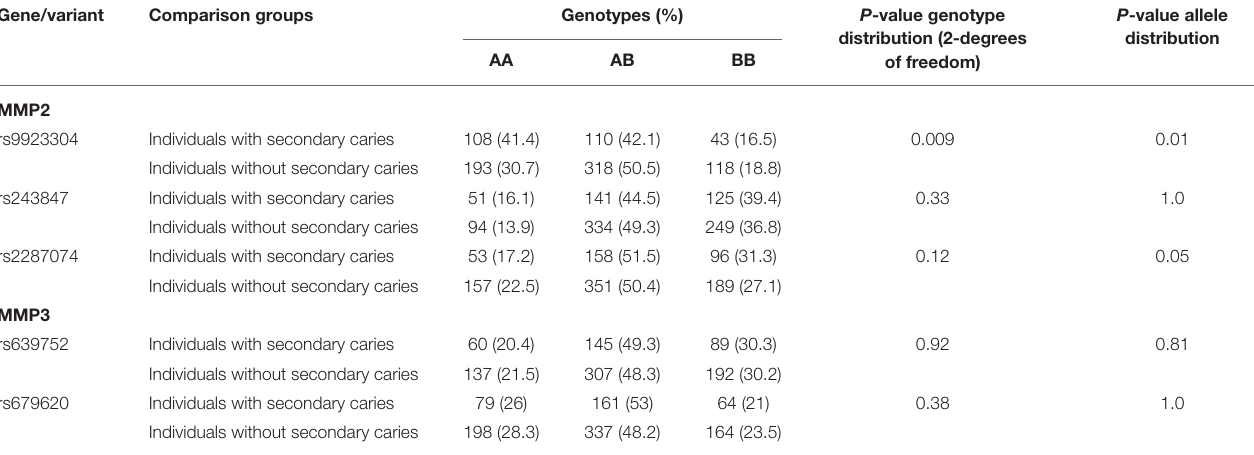
TABLE 2 | Genotypes* and summary results of association tests between secondary caries and MMP2 / MMP3